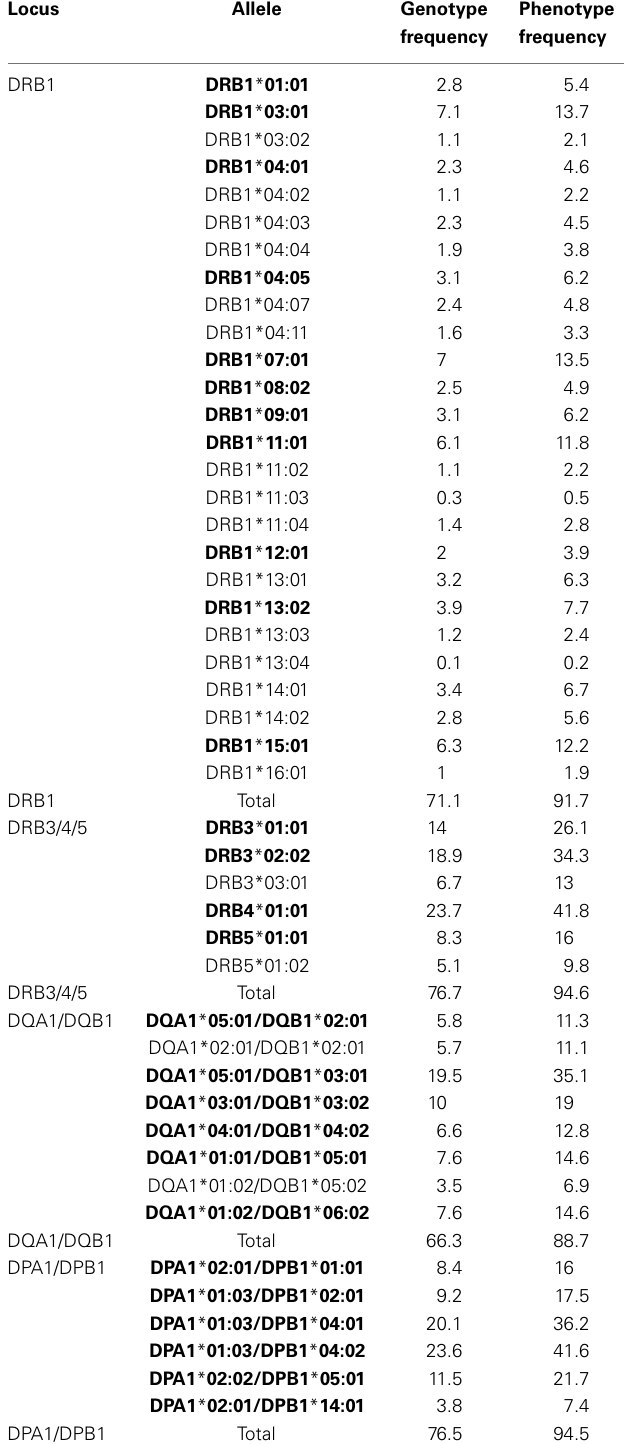
Table 1 | Genotype and phenotype frequencies of HLA class II